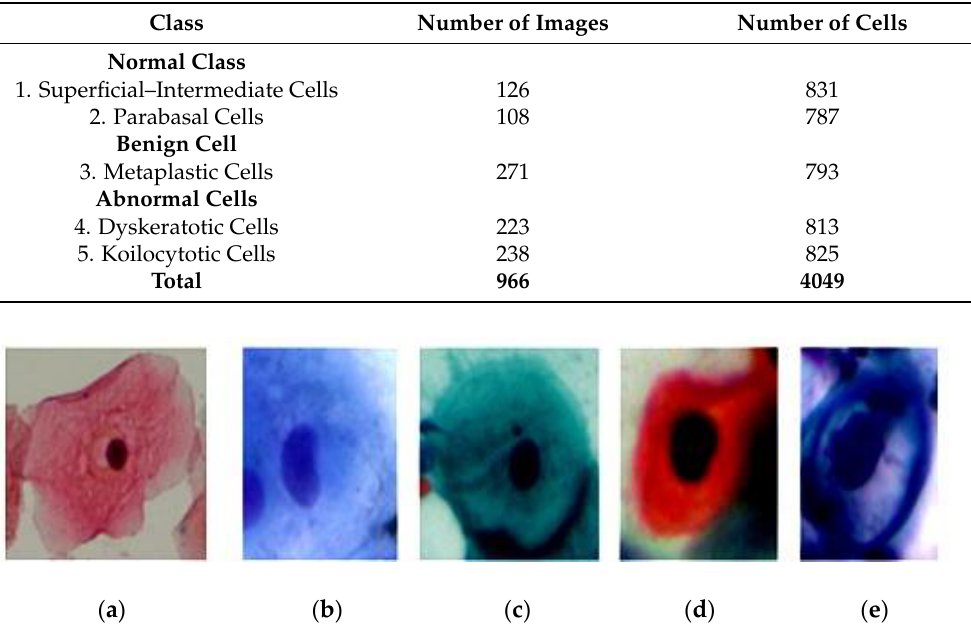
Figure 2. Example images from each class: ( a ) superficial, ( b ) parabasal, ( c ) metaplastic, ( d ) dysker- atotic, ( e ) koilocytotic.